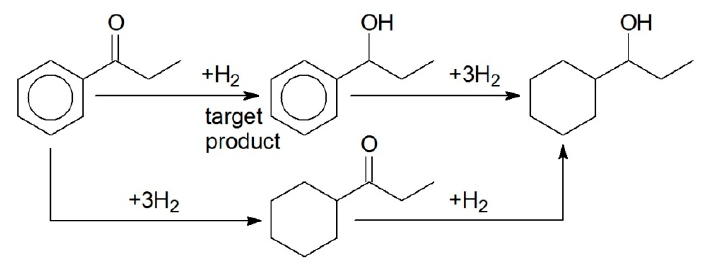
Figure 12. Scheme of selective hydrogenation of PP to PPL.